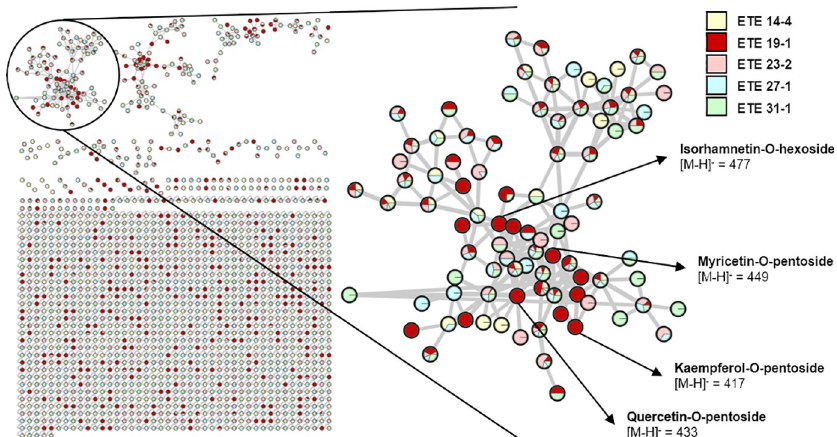
Fig 6. Molecular network of the 5 selected ethanolic extracts (SEs) of U . molinae fruits from different genotypes. The molecular network was created using the online workflow (https://ccms-ucsd.github.io/GNPSDocumentation/) on the GNPS website (http://gnps.ucsd.edu) and then exported to Cytoscape. Each node represents a precursor ion and clusters of related molecules were formed by analyzing the similarities among their fragmentation patterns. The area of each color in the nodes represents the abundance of the precursor in each extract. One cluster containing flavonol glycoside derivatives is shown in detail and some of the compounds identified only in ETE 19–1 are